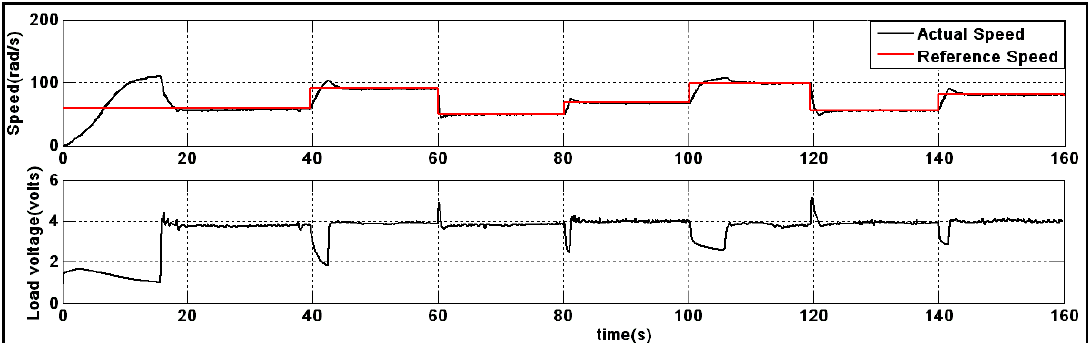
Figure 7. Speed tracking and load voltage under the SMC system.